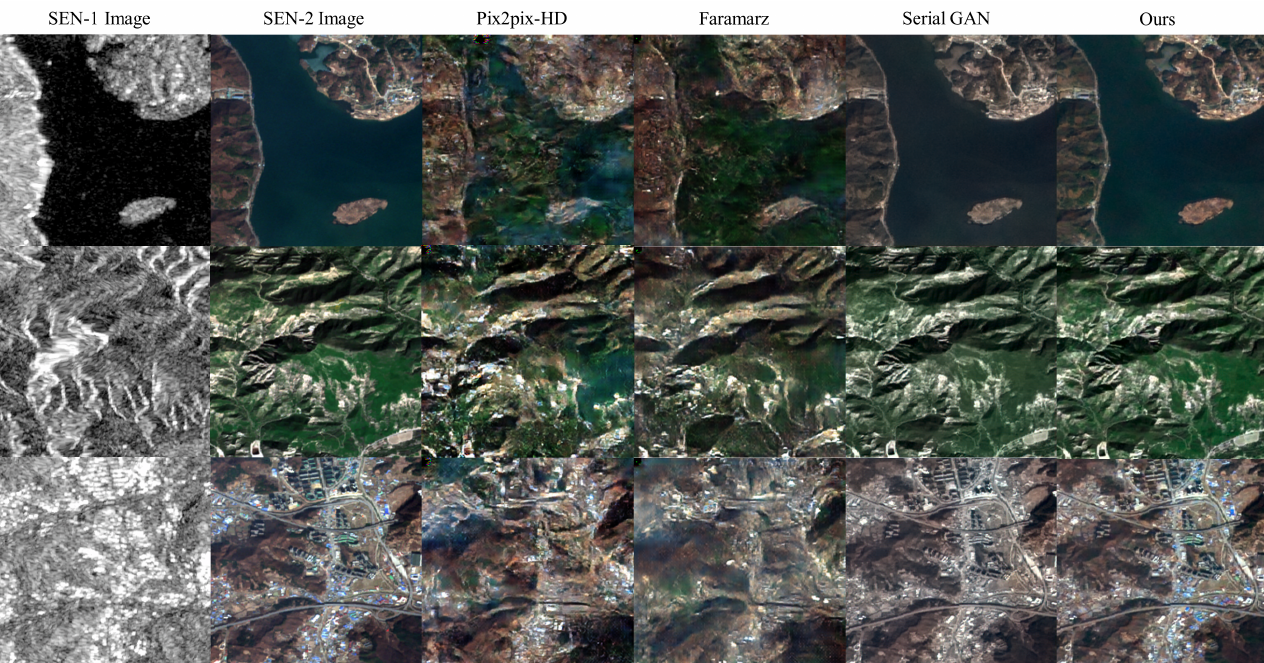
Figure 7. The results of different SAR-to-optical transformation models. The columns from left to right show SAR images, optical images, results of Pix2pix-HD, results of Faramarz et al. model, results of Serial GAN, and our results, respectively. The topography shown in the figure from top to bottom is: river valley, mountains and hills, and urban residential area. Best viewed in color.